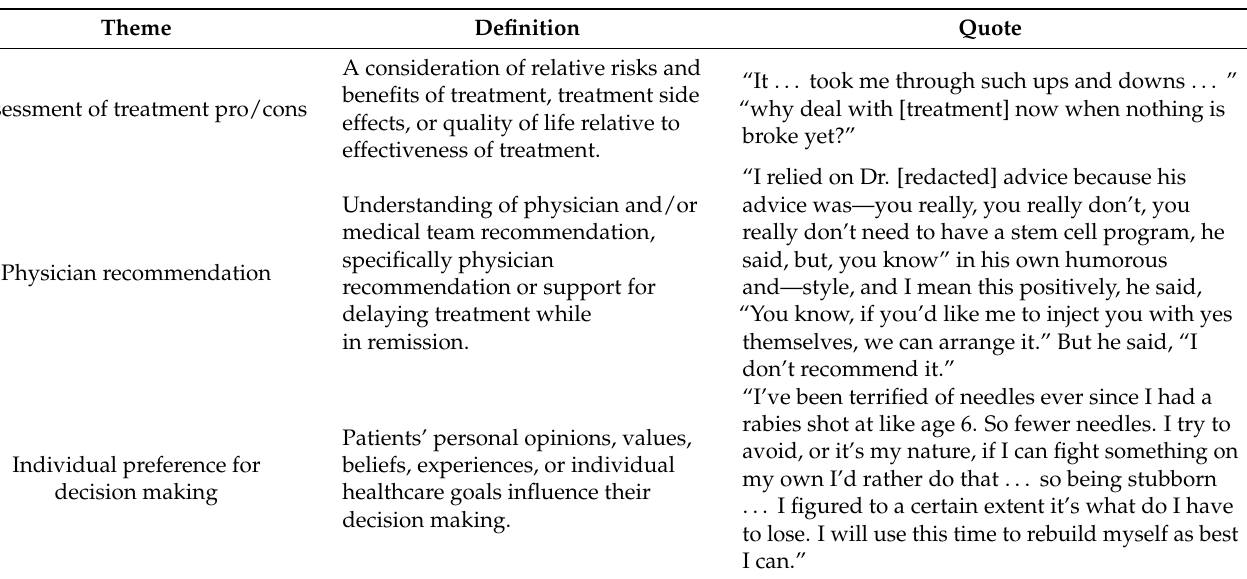
Table 2. Themes related to treatment underuse or